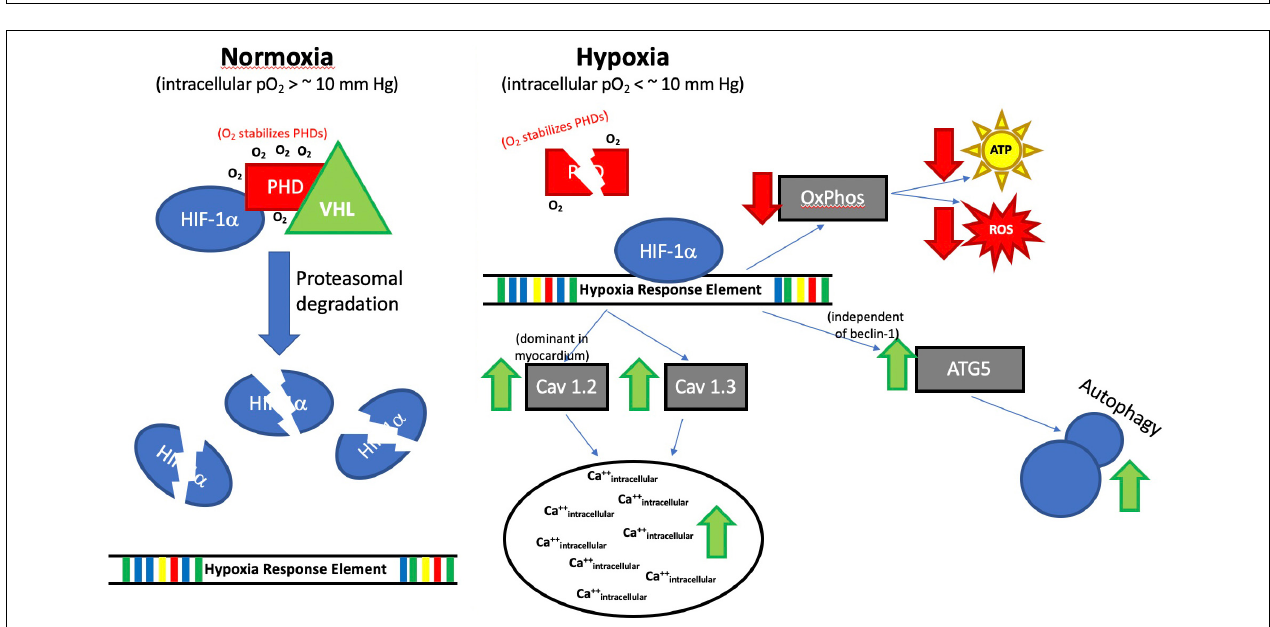
FIGURE 11 | Summary of the major observed Molecular and Cellular Response of Heart; Myocardium (H9c2) cells toward chemical (CoCl2)-and low oxygen Induced Hypoxia. The results shown for Hif1 α , Cav 1.1, Cav 1.2, Cav1.3, ATG5, and Becn1 are protein expression levels compared to control and experimental groups. ↑ increased; ↓ decreased; ns , not significant/no change. Hypoxia-inducible factor 1-alpha (Hif1 α ); Calcium (Ca2 +); calcium channel, voltage-dependent, L-type, alpha- 1S subunit, (CACNA1S) or (Cav 1.1); Calcium channel, voltage-dependent, L type, alpha-1C subunit (CACNA1C) or (Cav1.2); Calcium channel, voltage-dependent, L-type, alpha-1D subunit, (CACNA1D) or (Cav1.3); Adenosine triphosphate (ATP); Nicotinamide adenine dinucleotide phosphate (NADP)/Reduced nicotinamide adenine dinucleotide phosphate (NADPH); Reactive oxygen species (ROS); ATG5 (Autophagy Related 5); Beclin-1, Autophagy Related (Becn1); Mt-Nd1, mitochondrially encoded NADH dehydrogenase-1; Mt-Nd6, mitochondrially encoded NADH dehydrogenase 6.